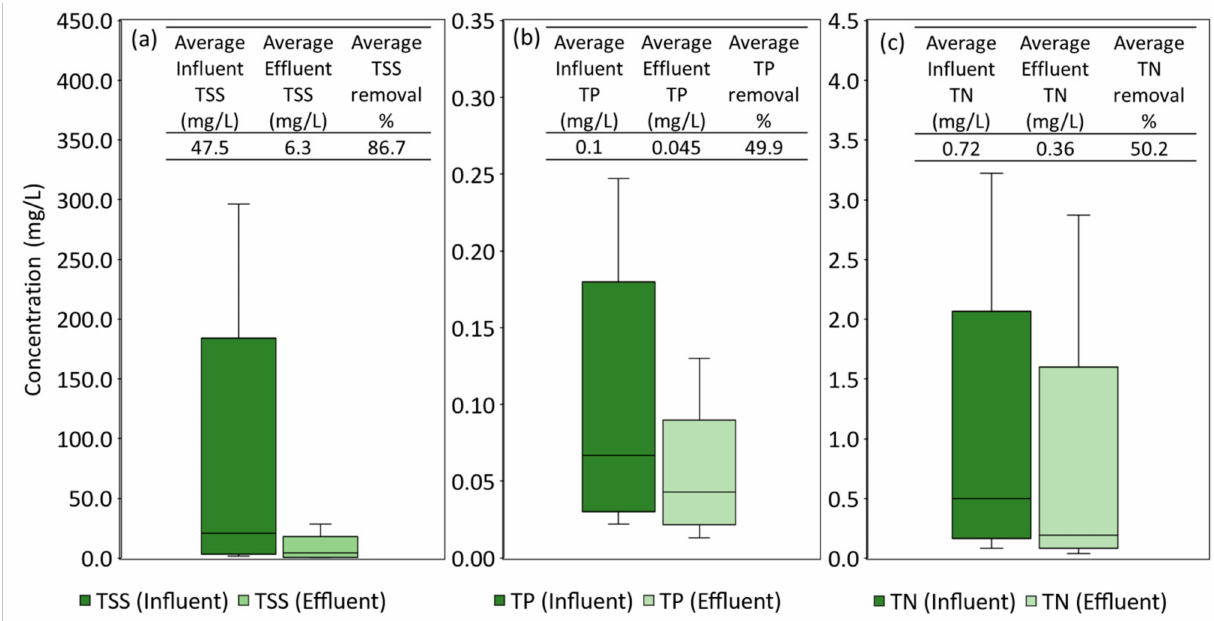
Figure 8. ( a ) TSS removal performance of field MBT, ( b ) TP removal performance of field MBT, and ( c ) TN removal performance of field